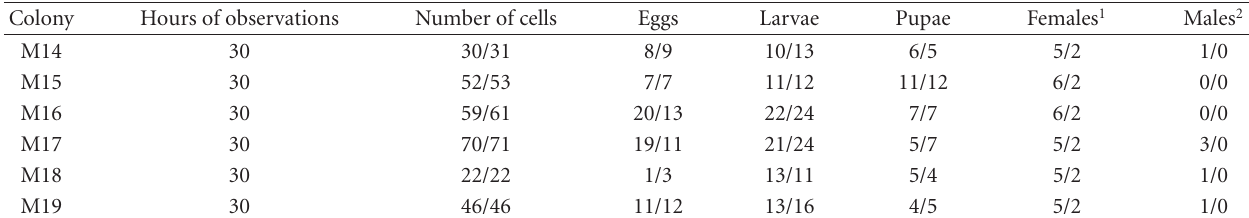
Table 1: Characteristics of the studied colonies in the beginning/end of the observations.